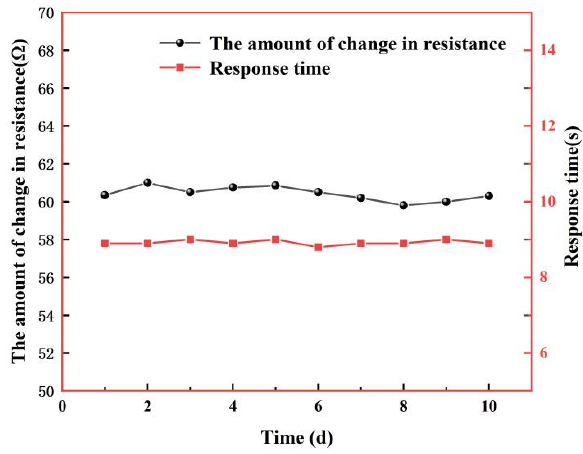
Figure 17. Stability test at 100 °C, 95%RH over 10 days.